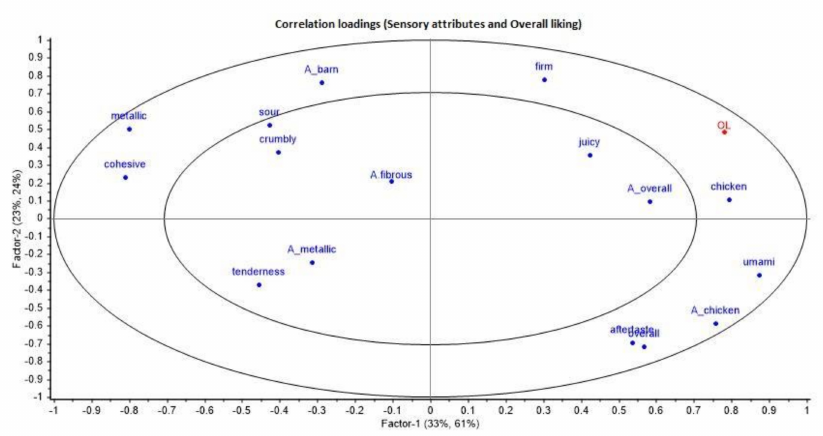
Figure 2. Correlation loadings for panel and consumer